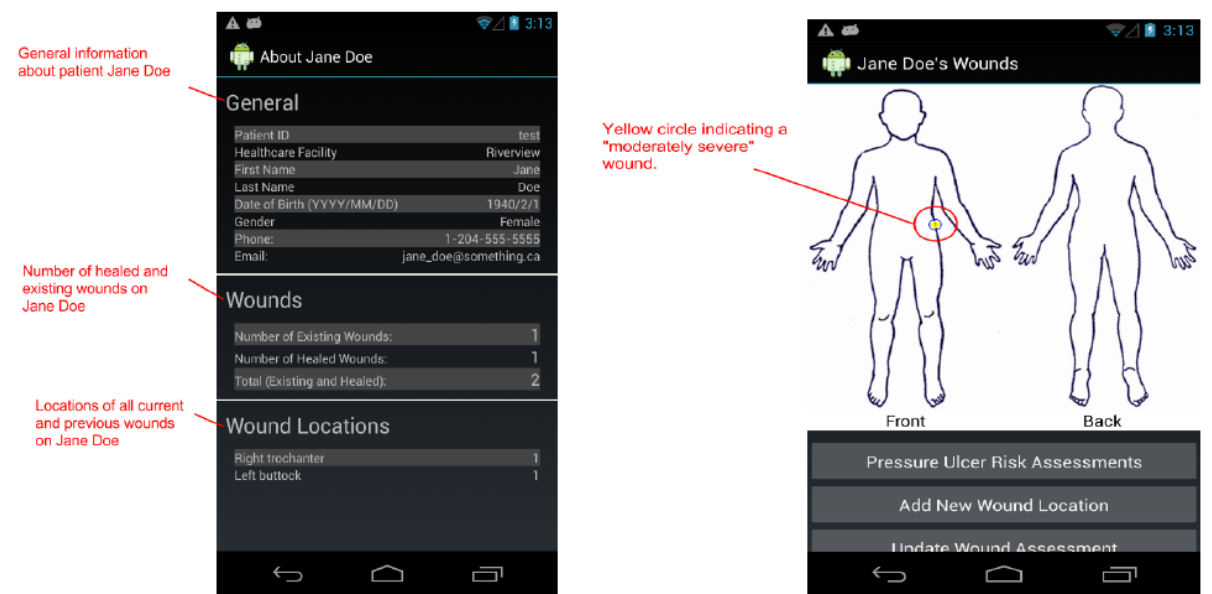
Figure 2. The Patient Info